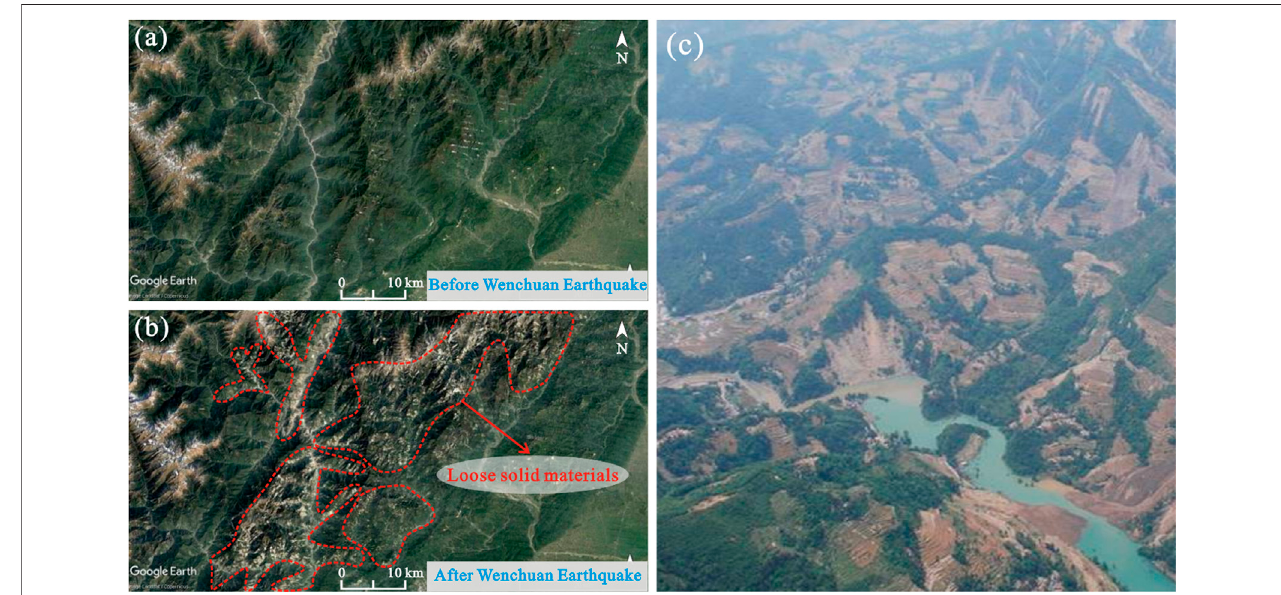
FIGURE 1 | Source conditions of loose solid materials in mountainous areas of southwestern China: (A) satellite image of the southwestern mountainous area before the Wenchuan earthquake; (B) satellite image of the southwestern mountainous area after the Wenchuan earthquake; and (C) typical topographic and geomorphologic conditions of the southwestern mountainous